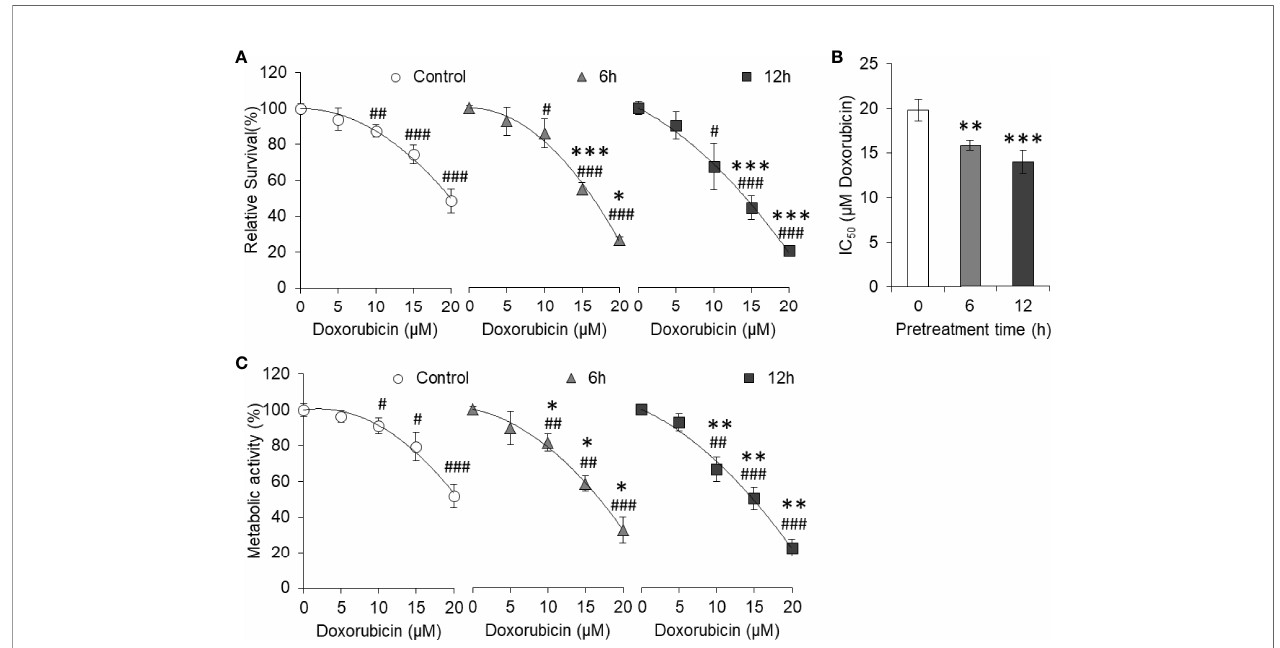
FIGURE 8 | Curcumin pretreatment prevents high glucose-induced chemoresistance. HepG2 cells treated for 6 or 12 h with curcumin were washed and plated at equal density in HG medium containing increasing concentration of doxorubicin. Cell survival was estimated using standard crystal violet assay (A) and calculation of IC 50 (B) . Metabolic activity of cells was also estimated using MTT assay (C) . The values shown are Mean ± SD of three independent experiments conducted in triplicate. * p < 0.05, ** p < 0.01, *** p < 0.001 vs values of cells not pretreated with curcumin. # p < 0.05, ## p < 0.01, ### p < 0.001 vs values of cells of not treated with